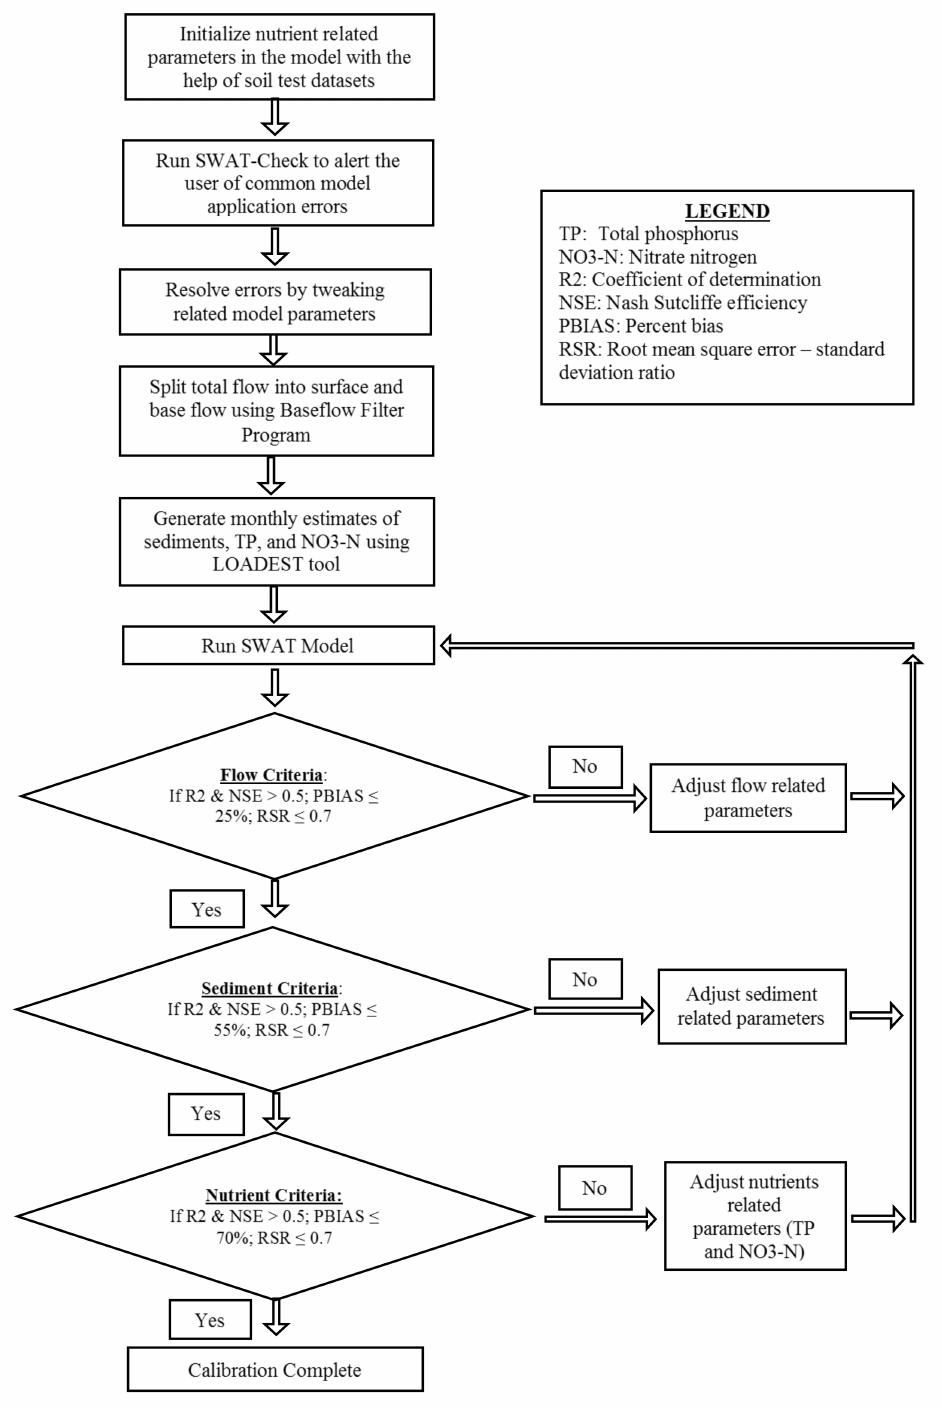
Figure 2. Flowchart depicting the revised calibration process at the monthly time step (modified from Engel, Storm, White, Arnold, and Arabi